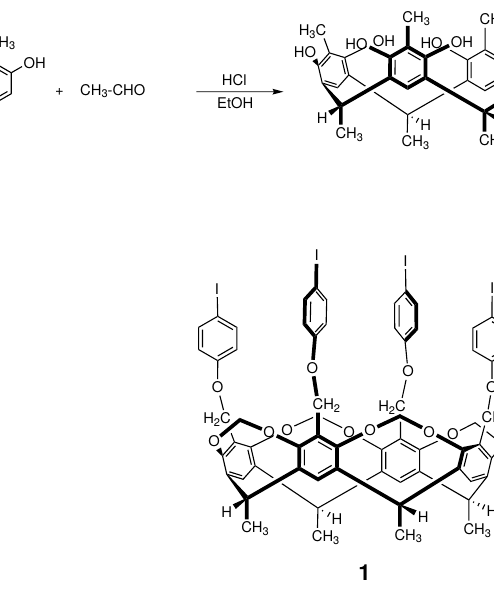
Figure 1. Synthesis of starting material (cavitand 1